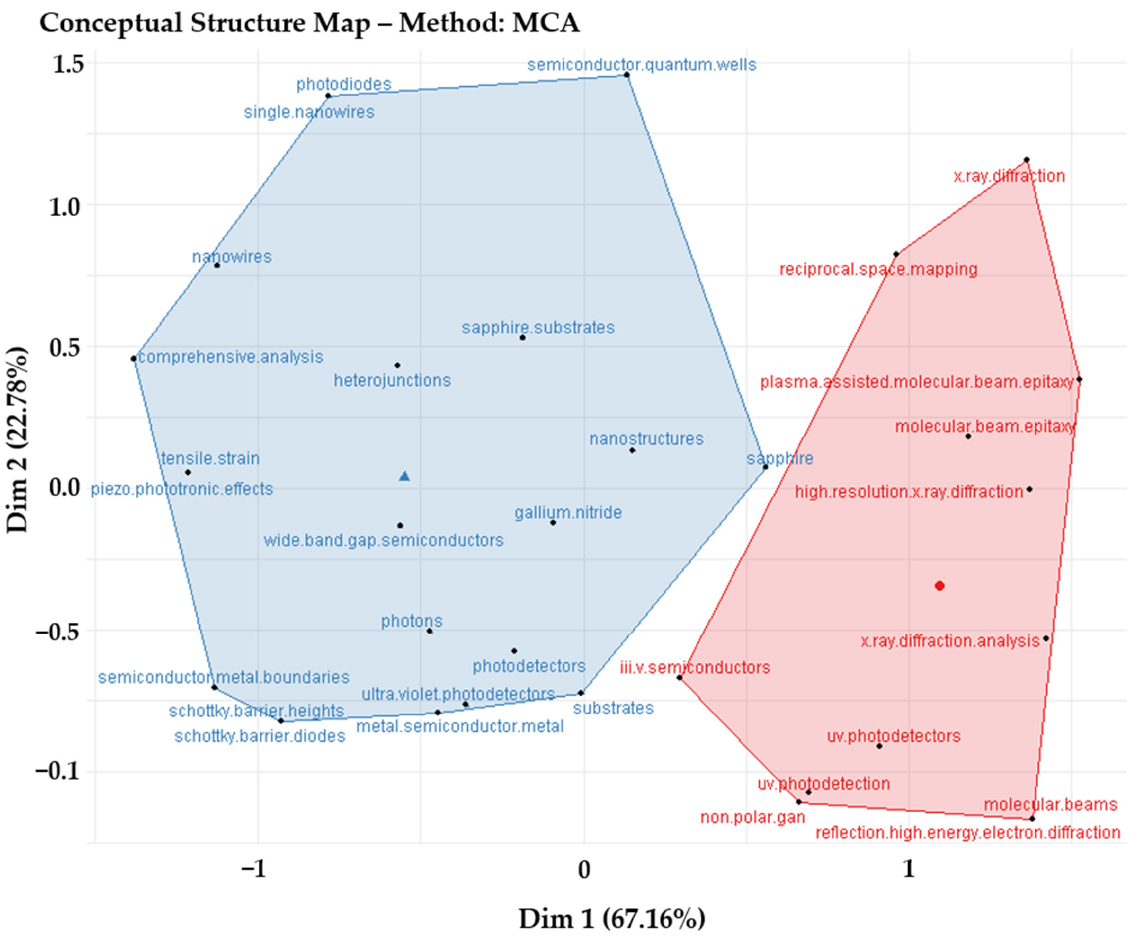
Figure 9. Conceptual map and keyword clusters of non-polar GaN-based photodetectors.